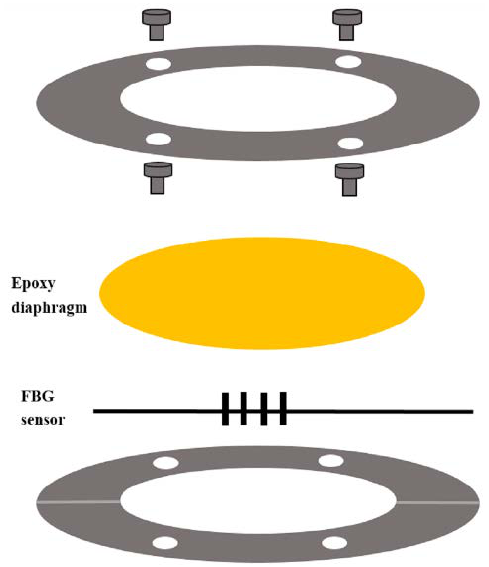
Figure 1. Schematic diagram of fiber Bragg grating (FBG) pressure sensor.